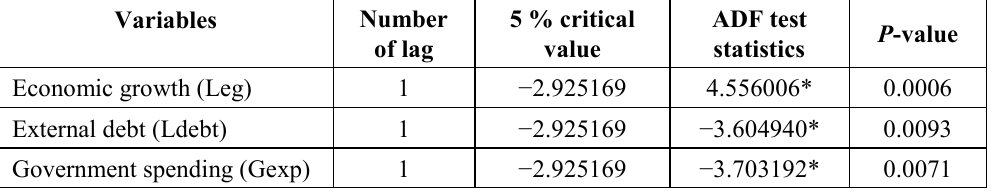
Table 3 . Augmented Dickey-Fuller (ADF) Test at Series First Differences Variables